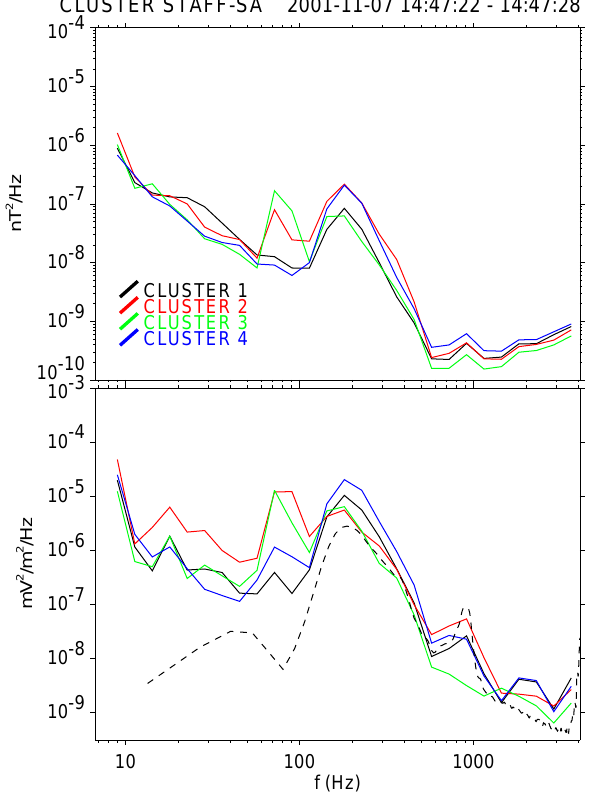
CLUSTER STAFF-SA 2001-11-07 14:47:22 - 14:47:28